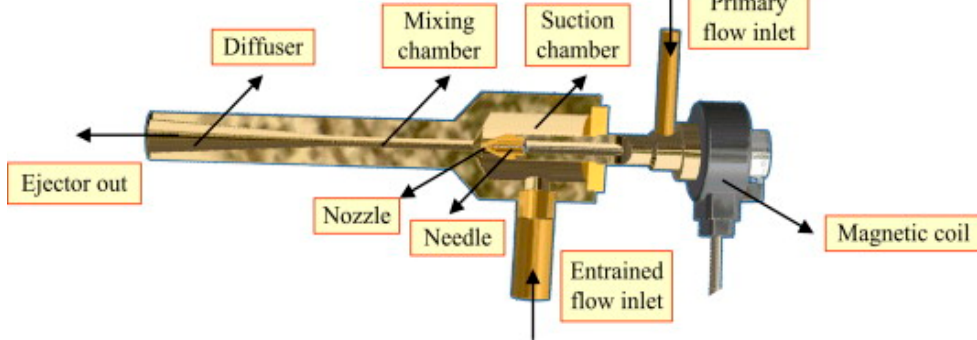
Figure 5. 3-D model of the adjustable ejector. Reproduced with permission from [99]. Elsevier, 2012.